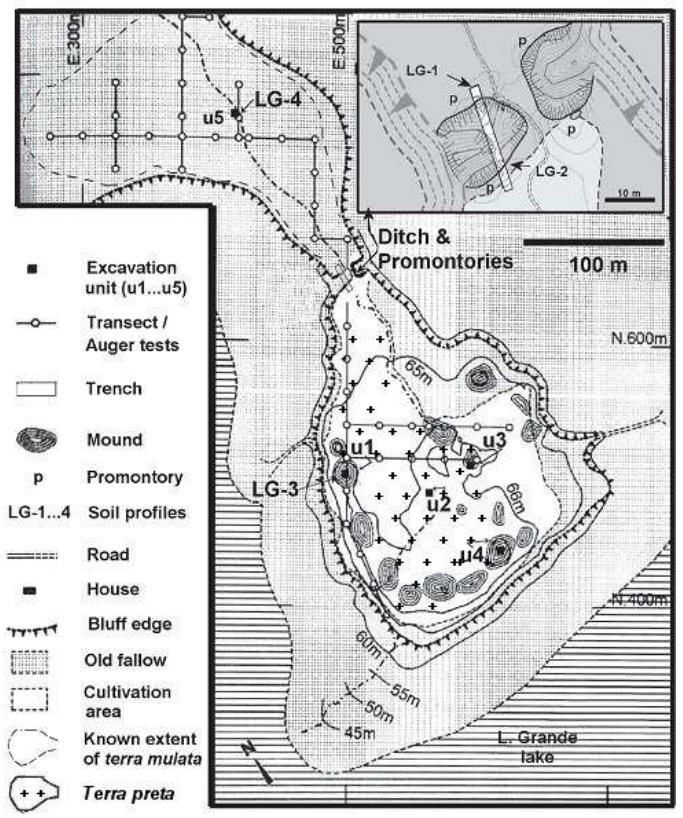
Figure 3. A plan of the Lago Grande site [adapted from 103] showing the distribution of terras pretas and terras mulatas , as well as sampling points discussed in the